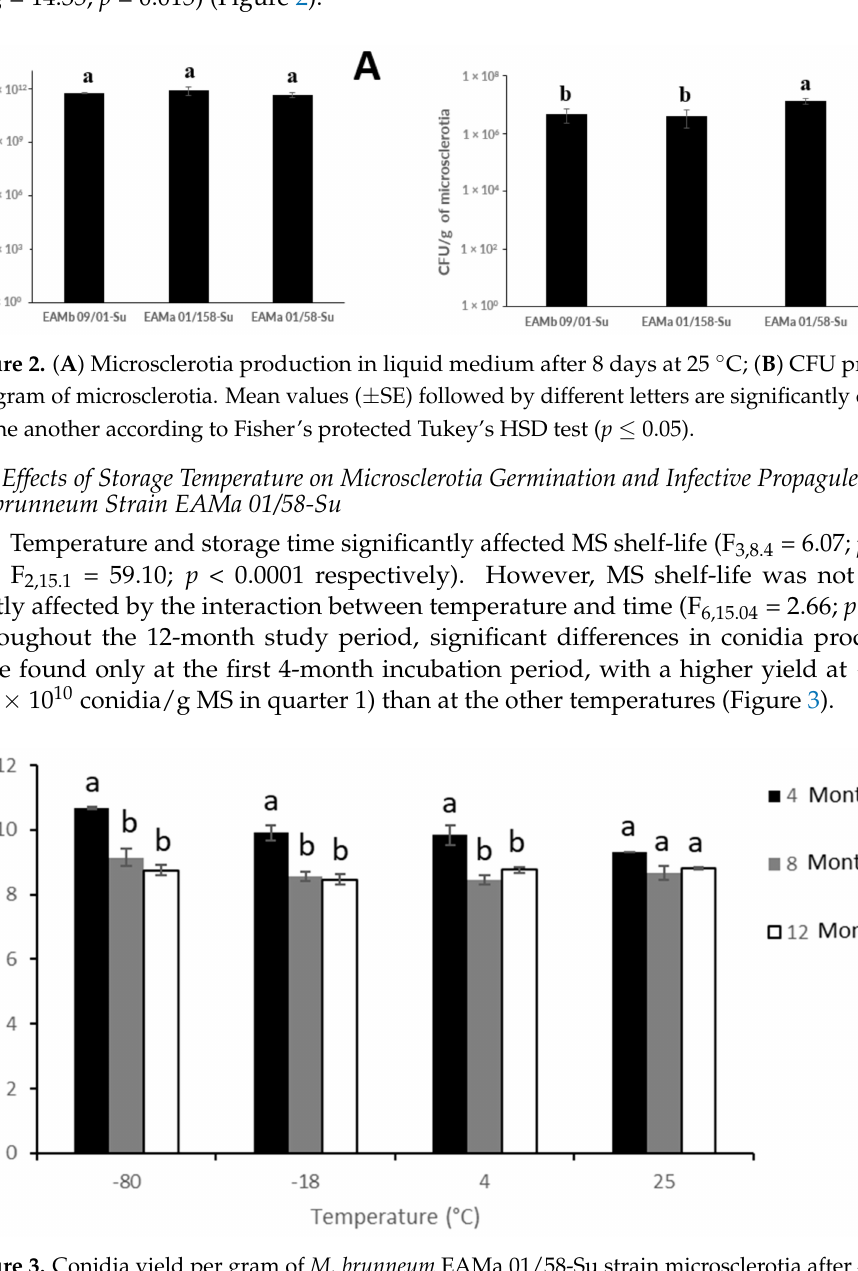
Figure 3. Conidia yield per gram of M. brunneum EAMa 01/58-Su strain microsclerotia after 4, 8, and 12 months at − 80 ◦ C, − 18 ◦ C, 4 ◦ C, and 25 ◦ C. Mean values ( ± SE) within temperature followed by different letters are significantly different to one another according to the mean separation test with 95% protected by Tukey’s HSD range test ( p ≤